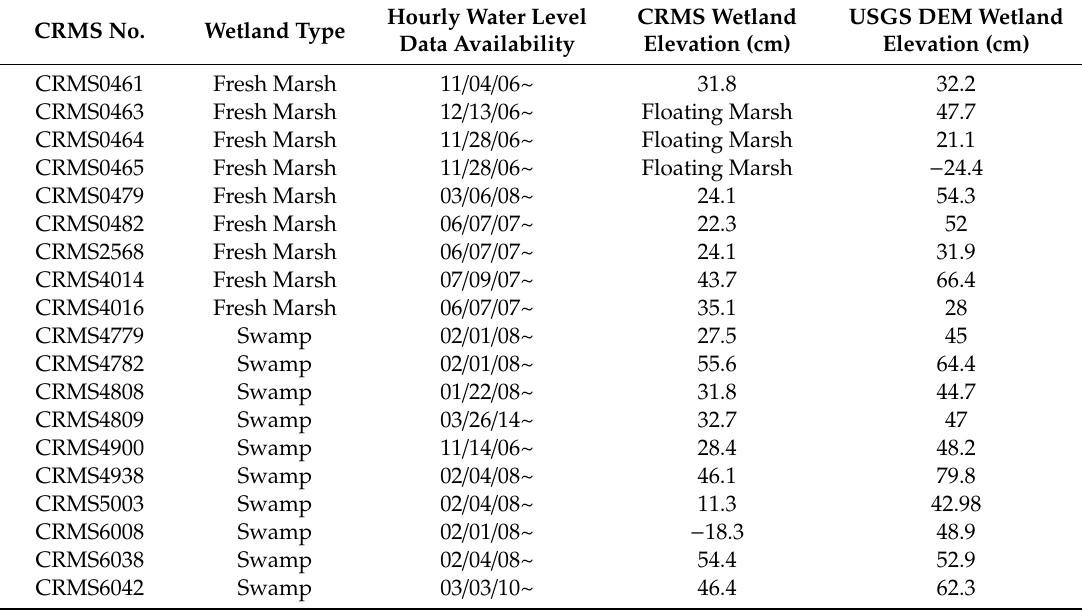
Table 1. In situ measurements from the Coastwide Reference Monitoring System (CRMS) & the USGS